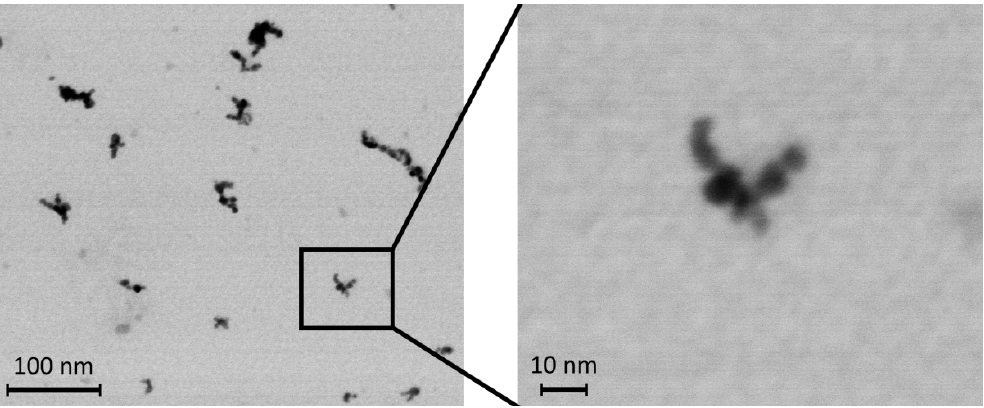
Figure 1. Transmission electron micrograph of TiO 2 NPs deposited on the TEM